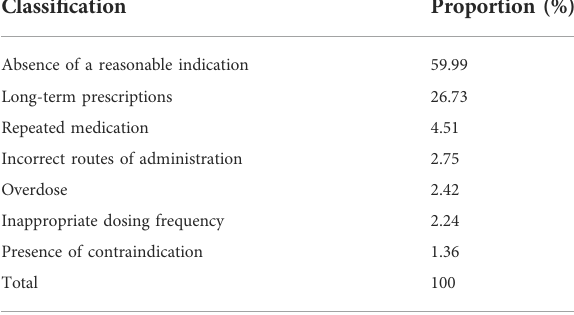
TABLE 1 The classi fi cation of inappropriate prescriptions not passed by preview